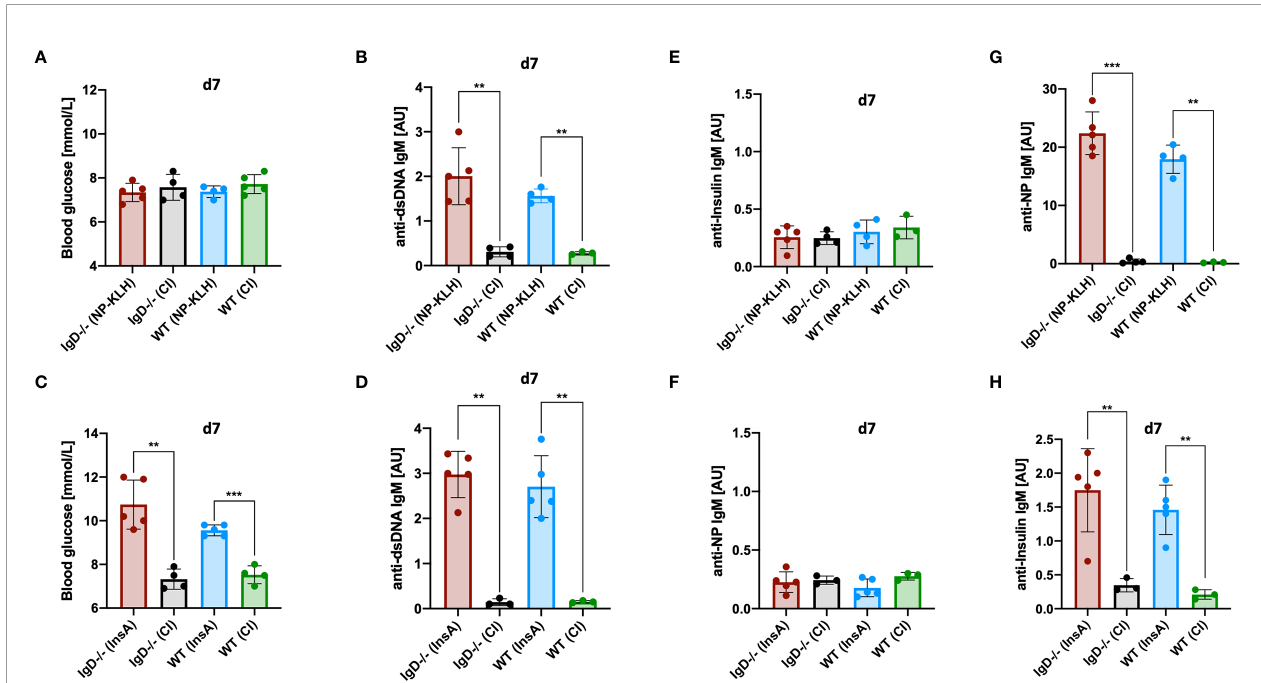
FIGURE 7 | Primary IgM is antigen-speci fi c and polyreactive but not cross-reactive. (A, C) Blood glucose levels (mmol/L) of IgD-de fi cient and WT mice immunized with NP-KLH + CpG and controls (CpG-ODN1826) (A) , or immunized with InsA-KLH + CpG and controls (C) . Mean, ± SD, statistical analysis was done by using Kruskal-Wallis-test. (B, D) Serum immunoglobulin titers of IgD-de fi cient and WT mice immunized with either NP-KLH + CpG and controls (B) or InsA-KLH + CpG and controls (D) reactive to dsDNA measured by ELISA. Mean, ± SD, statistical analysis was done by using Kruskal-Wallis-test. (E – H) Serum immunoglobulin titers of IgD-de fi cient and WT mice immunized with either NP-KLH + CpG or InsA-KLH + CpG and controls reactive to Insulin (top panel) or InsA-KLH + CpG and controls immunized mice reactive to NP (bottom) (E, F) and reactive to NP or Insulin (G, H) measured by ELISA. Mean, ± SD, statistical analysis was done by using Kruskal- Wallis-test **P < 0.01, ***P <